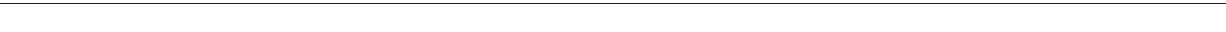
Fig. 1 FANCM is important for suppressing Flex1-induced mitotic recombination independent of the FA core complex and ID2 complex. a Schematic drawing of the EGFP-based HR-Flex and HR-Luc reporters as previously described 10 . Luc: luciferase fragment; D-EGFP: donor EGFP. b , c shRNAs for indicated proteins or a control vector (Ctrl) were expressed in U2OS ( b ) or Hela and MCF7 ( c ) cells containing the HR-Flex reporter, and assayed for spontaneous mitotic recombination after culturing for 3 or 12 days. The expression of indicated protein was examined by western blot analysis. d Spontaneous recombination was examined in HCT116 wild-type (WT) and HCT116 FANCM KO cells carrying the HR-3B/AT (AT-rich sequences derived from FRA3B) reporter after culturing pre-sorted non-green cells for indicated days. e , g Spontaneous recombination was assayed in U2OS (HR-Flex) cells expressing Flag-FANCM WT or indicated mutants 12 days after endogenous FANCM was silenced by shRNA. The expression of Flag-FANCM WT and indicated mutants is shown by western blot analysis. f The cell lines described in b were infected with I-SceI retroviruses and assayed for HR 5 days later. In all experiments, error bars represent standard deviation (SD) of at least three independent experiments. The P value is indicated as * P < 0.05 and ** P < 0.01. n.s. not signi fi cant. Western blot analysis was performed using β -actin or Ku70 as a loading